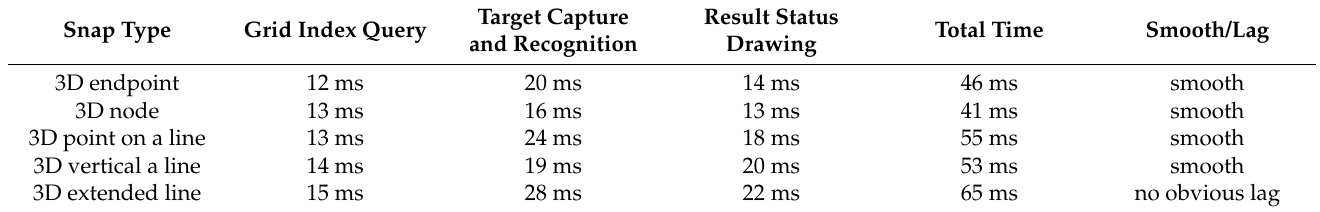
Table 2. Average time consumption of the snap algorithm in the subprocess for twenty